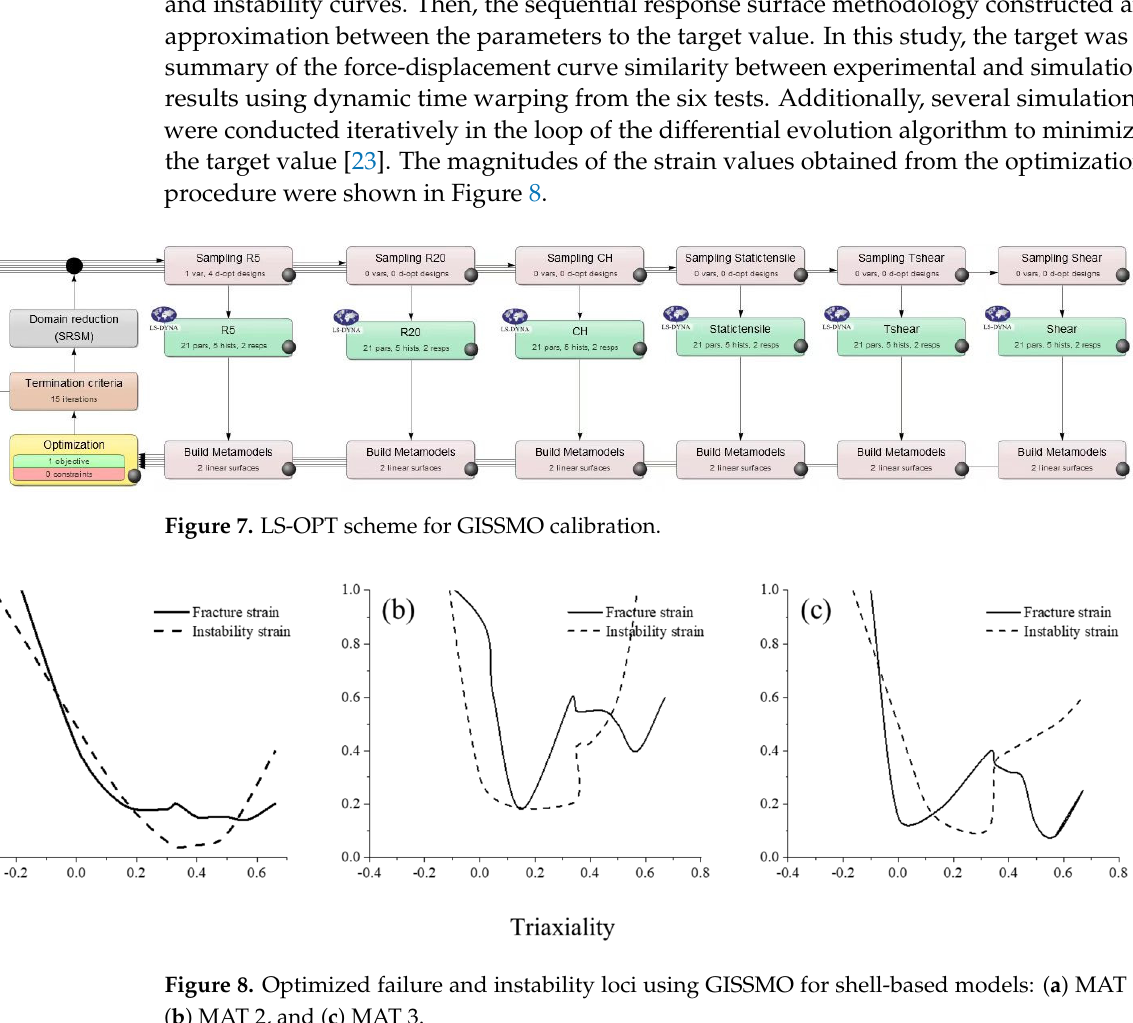
Figure 9. Shell-based model simulation vs. experiments for MAT 1 using GISSMO: (a) shear specimen, ( b ) tensile specimen, ( c ) center hole specimen, and ( d ) R5 specimen.